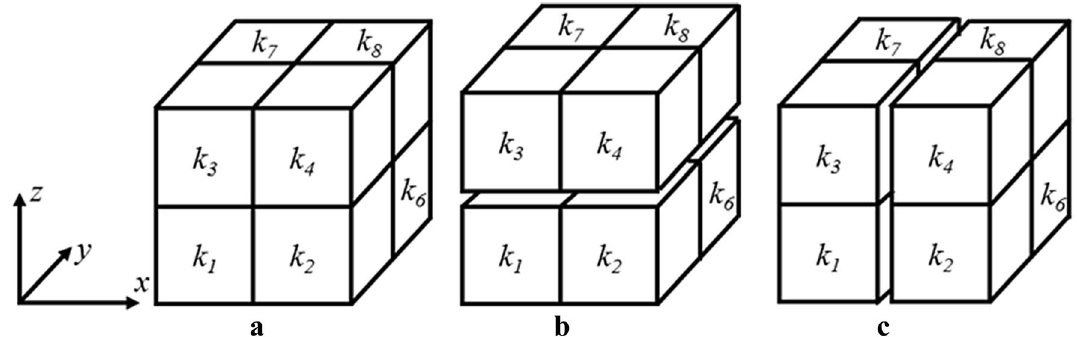
Fig. 1 Schematic illustration of the two-dimensional renormalization blocks used in the approximation of the three-dimensional renormalization (Green and Paterson